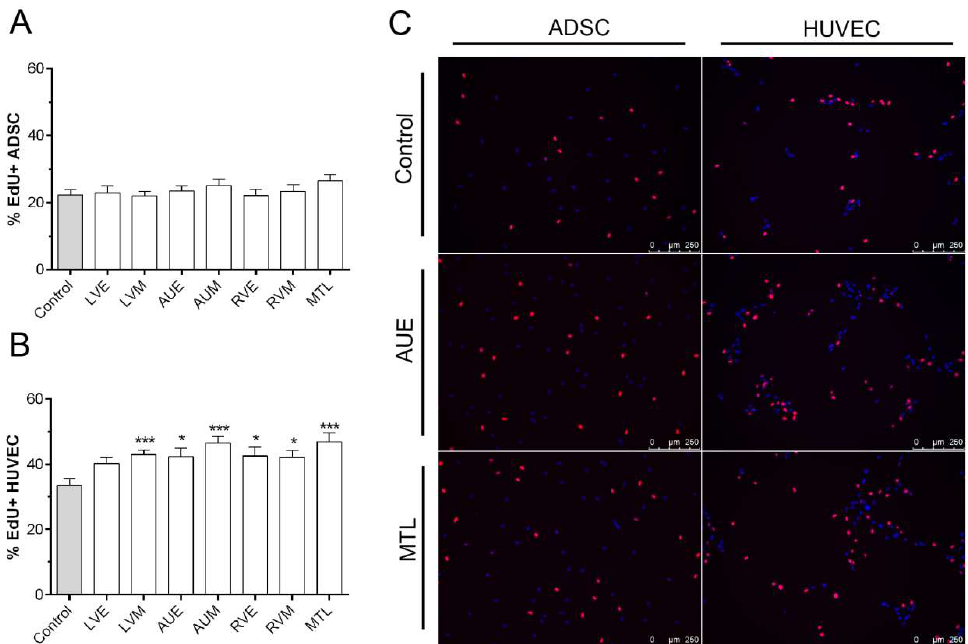
Figure 5. Influence of hH-EVs derived from cardiac regions on ADSC and HUVEC proliferation. Analysis of the percentage of EdU+ ( A ) ADSCs and ( B) HUVECs cells after 24 h. ( C ) Representative images of EdU+ cells (red) stimulated by extracellular vesicles derived from right auricle endocardium (AUE) and mitral valve leaflet (MTL). * p < 0.05, *** p < 0.001.